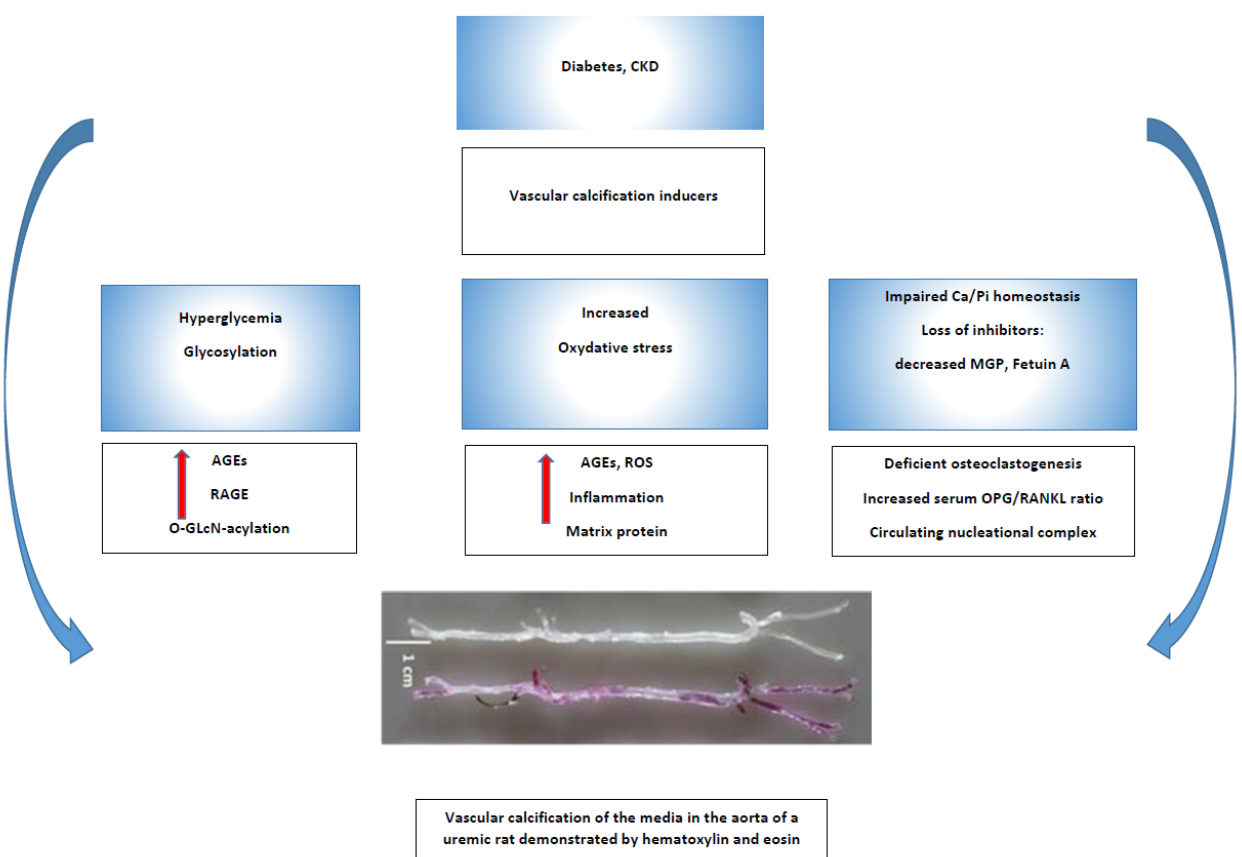
Figure 1. Factors involved in vascular calcification associated with diabetes mellitus (picture of aorta from the service of nephrology and hypertension, Lausanne).